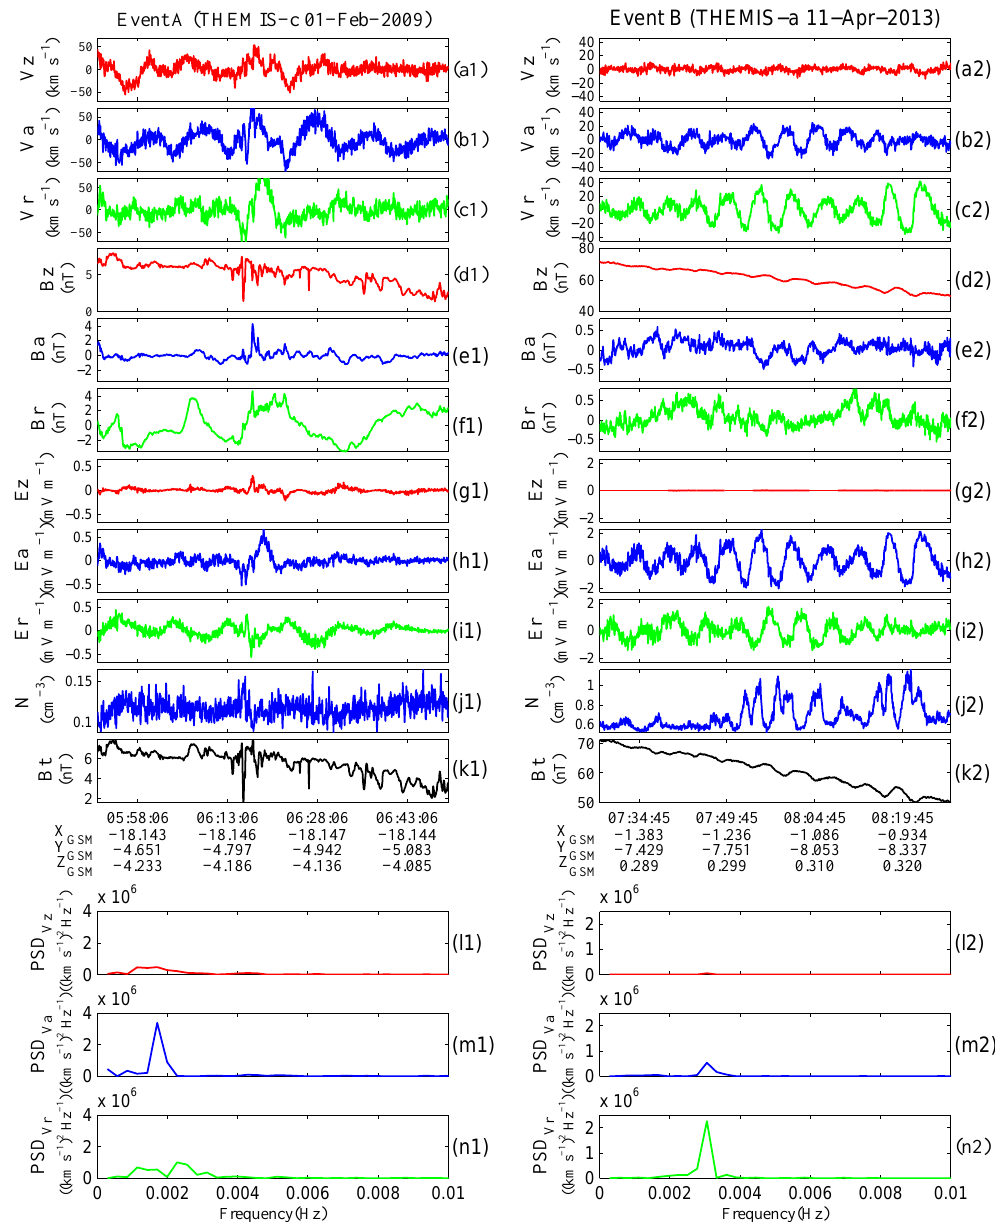
Figure 2. Examples of an azimuthal oscillating event (Event A) from 05:50 to 06:50UT on 1 February 2009 and a radial oscillating event (Event B) from 07:28 to 08:28 on 11 April 2013. (a–c) represent velocity components, (d–f) magnetic components, (g–i) electric field components, (j) total ion density, (k) total magnetic field, and (l–n) FFT analysis of ion velocity.